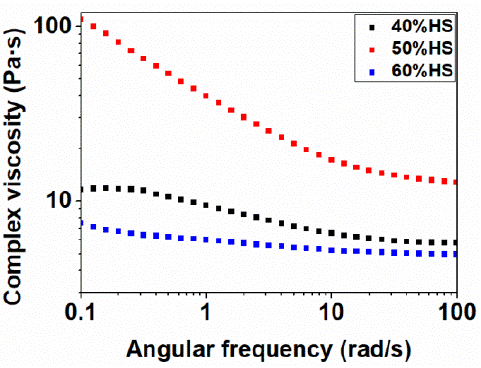
Figure 4. Complex viscosity as a function of the angular frequency for TPUs with different HS%.